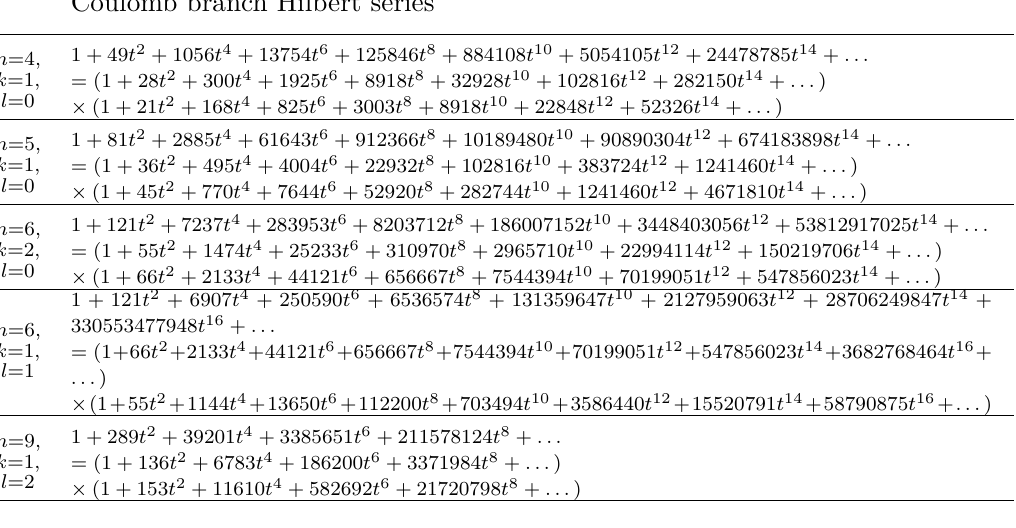
Table 15. Hilbert series results for (3.6). The first line displays the Coulomb branch Hilbert series for (3.6), while the second line displays the factorisation. Each factor agrees with the known Hilbert